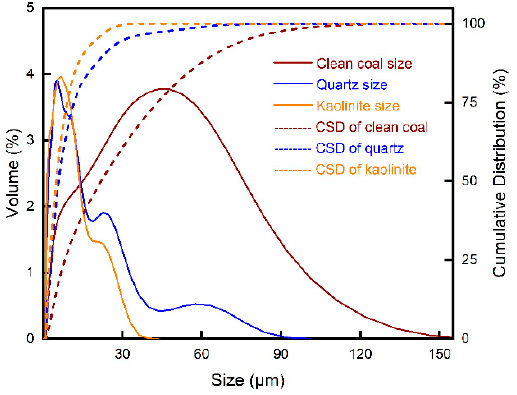
Figure 2. Size distribution of coal slime (ultrafine coal).